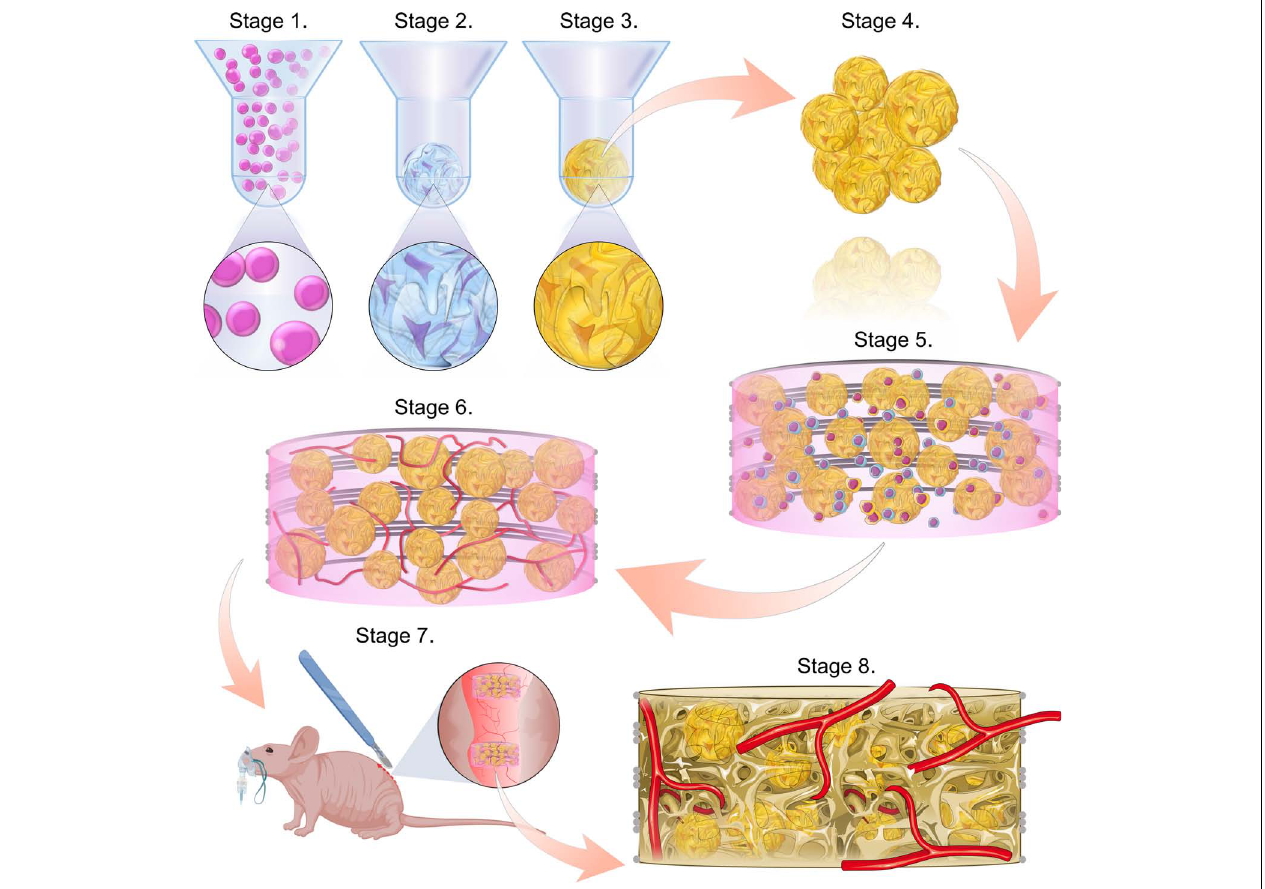
FIGURE 1 | Study schematic. Stages 1–3 consist of the formation of the microtissues, starting with cell seeding the microwells (stage 1), followed by the chondrogenic differentiation of the cell spheroids (stage 2) and ultimately the hypertrophic maturation of the cartilage microtissues (stage 3). Stage 4 involves harvesting the hypertrophic cartilage microtissues from the microwells. These are then combined with a co-culture of HUVECs and hMSCs within a bioink and incorporated into a PCL framework (stage 5). This implant is then cultured for a further week, in the presence of VEGF to form a prevascular network (stage 6). This prevascularised implant is then ready for implantation (stage 7). Bone formation and vascularisation within the implants are evaluated at 4- and 8-week time points (stage